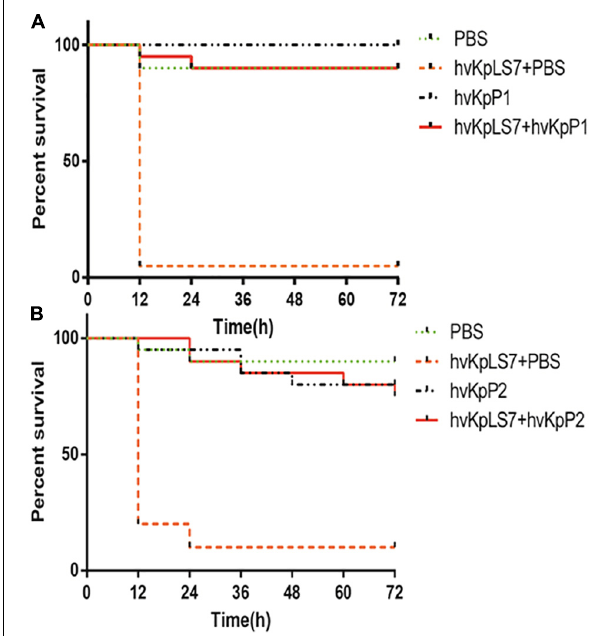
FIGURE 3 | Survival of G. mellonella larvae after infection by hvKp hvKpLS7 and phage therapy. Treatment by (A) hvKpP1 and (B)